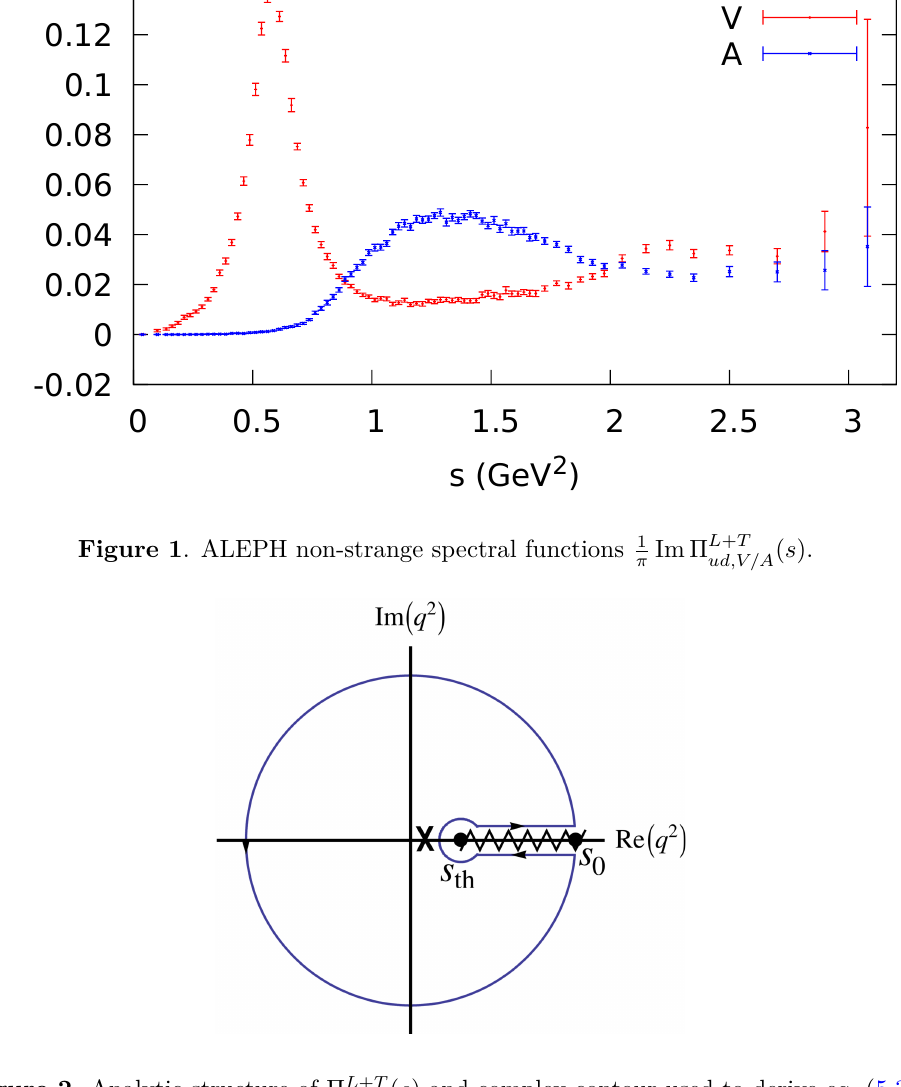
Figure 2 . Analytic structure of Π L + T ( s ) and complex contour used to derive eq.